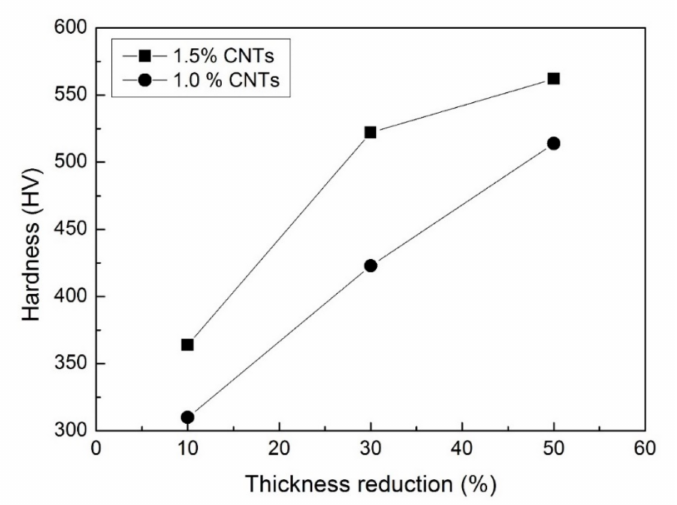
Figure 3. Hardness variation as a function of the CNT percentage and of the thickness